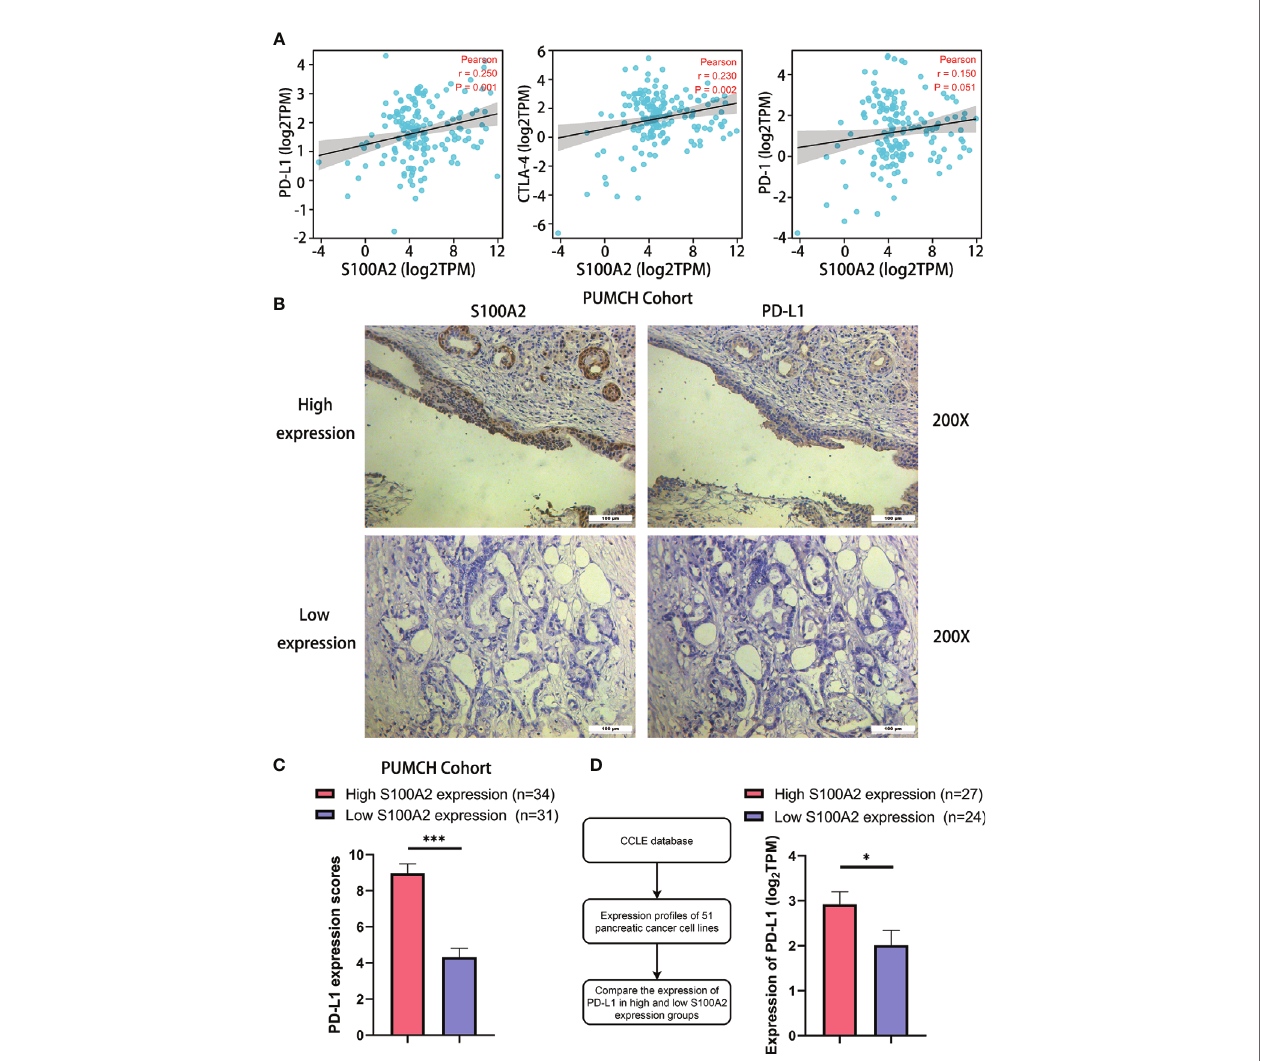
FIGURE 8 | Correlation between S100A2 expression and PD-L1 expression in PC. (A) Correlation analysis between the expression of S100A2 and immune checkpoint, including PD-L1, PD-1 and CTLA-4. (B) Representative images of positive correlation between S100A2 and PD-L1 expression in sequential sections of PUMCH cohort. (C) Expression difference of PD-L1 in high and low S100A2 expression groups in PUMCH cohort (n = 65). (D) Expression difference of PD-L1 in pancreatic cancer cell lines with high and low S100A2 expression. *P < 0.05; ***P <